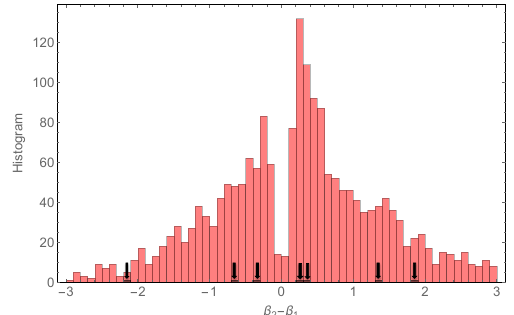
Figure 6. Differences in β 2 and β 1 for a Monte Carlo ensemble with 2000 members of synthetic LRM processes with β = 0.7. The black arrows indicate the differences from the multiproxy recon-